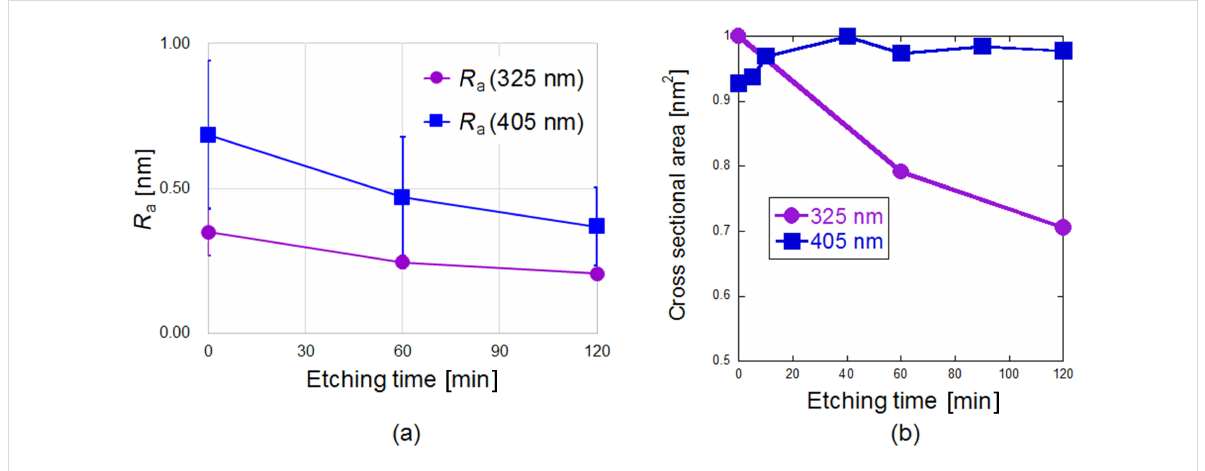
Figure 3: (a) Evaluation of surface roughness reduction of 325 nm (purple) and 405 nm (blue) over a 2 h interval. (b) Showing the cross-sectional etching volume. A comparison of the etching volumes of 325 nm (purple) and 405 nm (blue) over a 2 h interval.